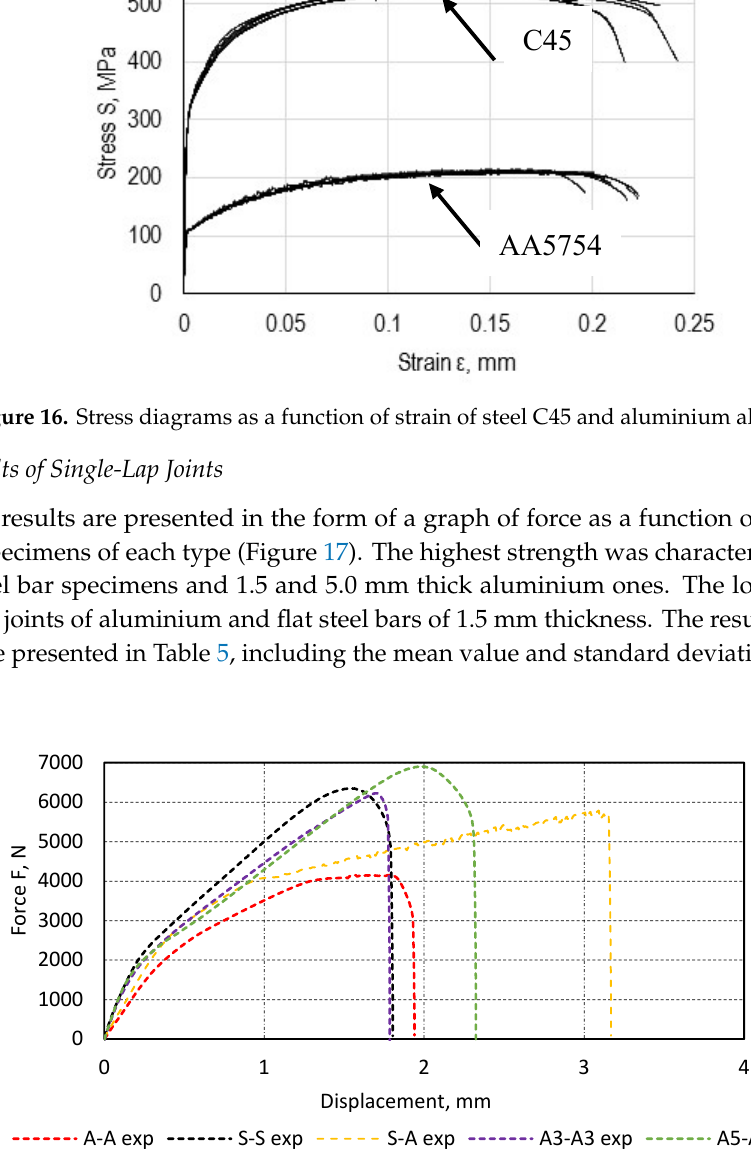
Figure 17. Exemplary test results for single-lap joint specimens.